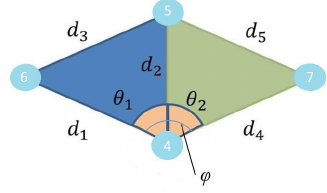
Fig. 3. The angle between shoulders is computed as the angle φ between markers RSHD(6), C7(4), and LSHD(7),